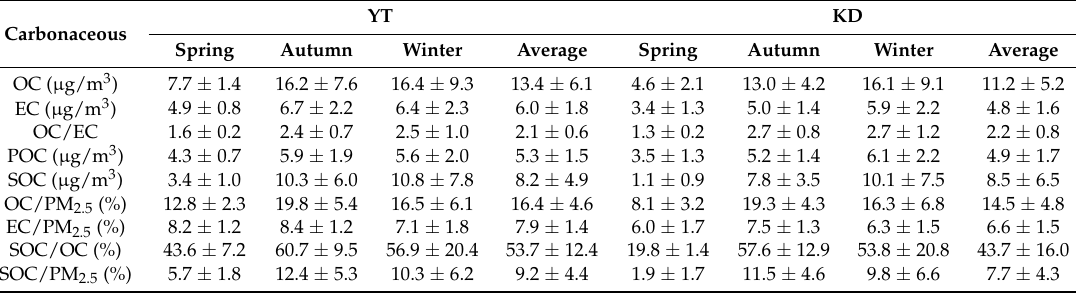
YT KD Carbonaceous Spring Autumn Winter Average Spring Autumn Winter Average OC (µg/m 3 )